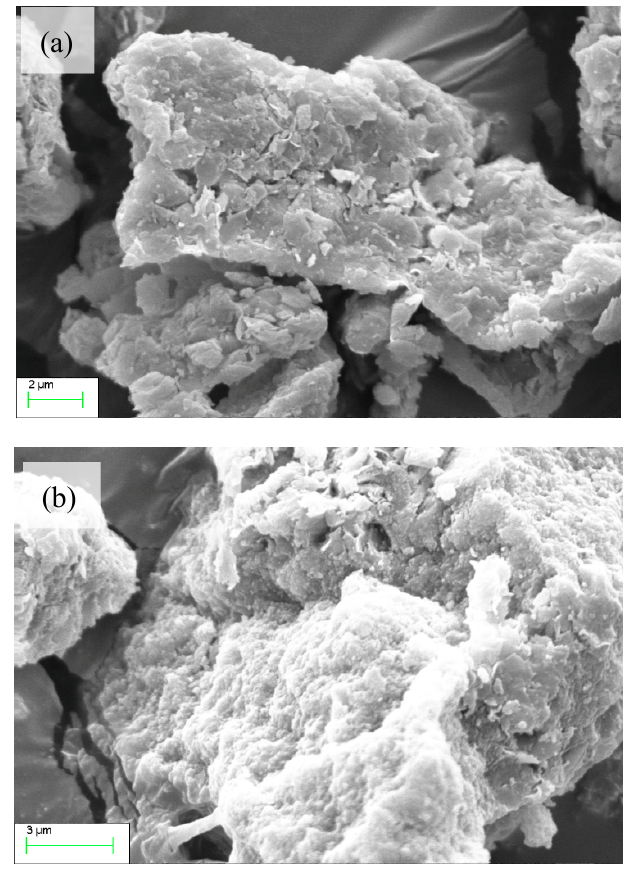
Figure 6. The scanning electron microscopy (SEM) of MMT ( a ) and organic montmorillonite (OMMT) ( b ).